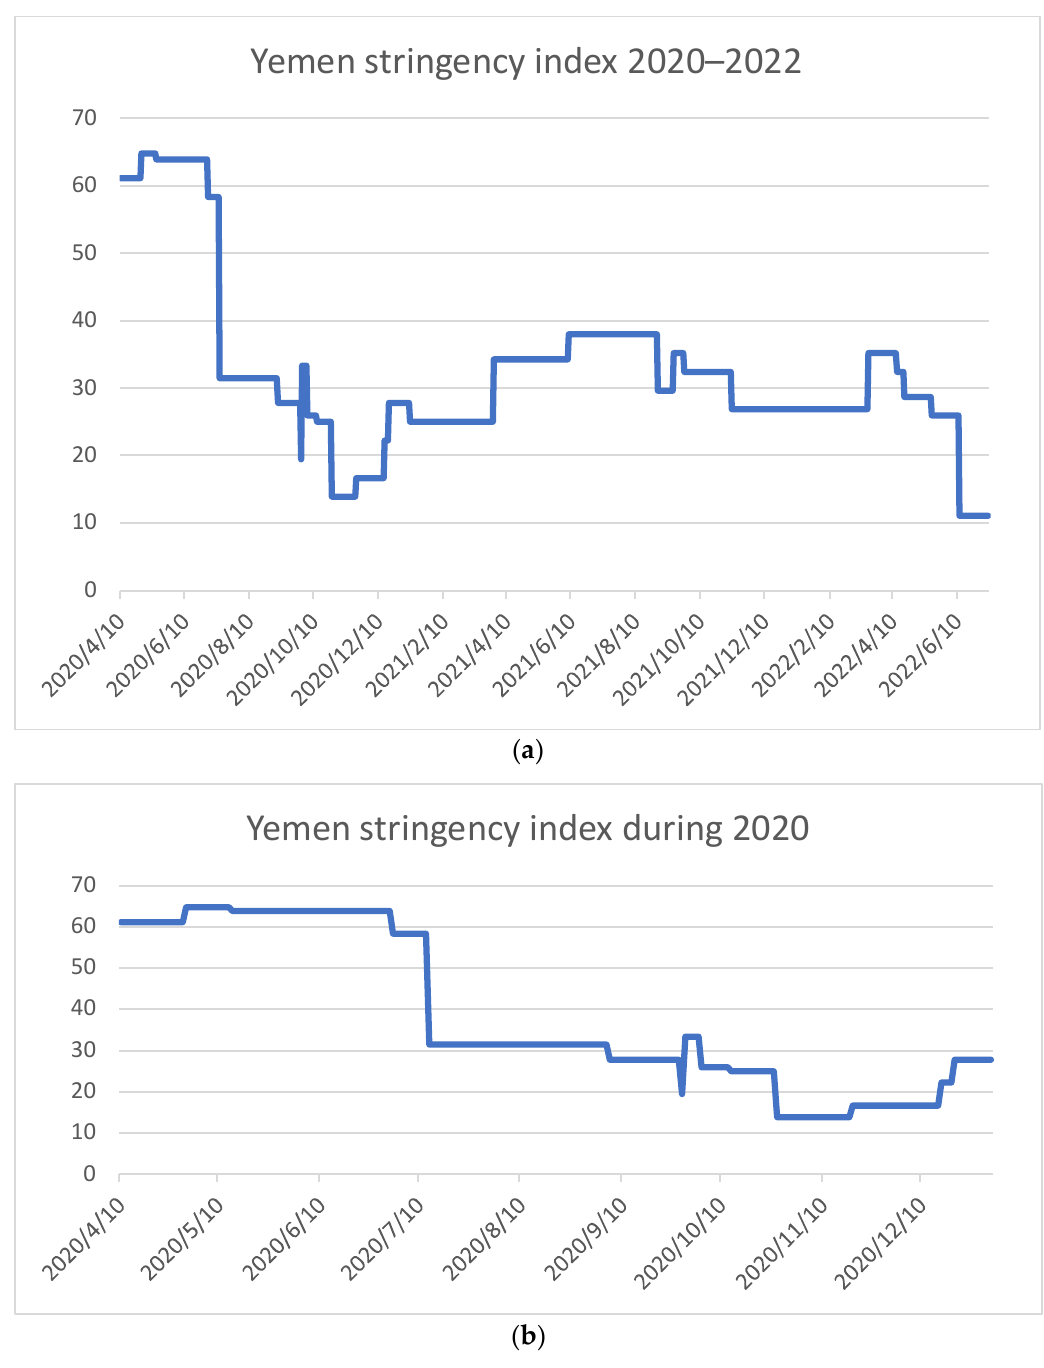
Yemen stringency index during 2021 Figure 1. Cont